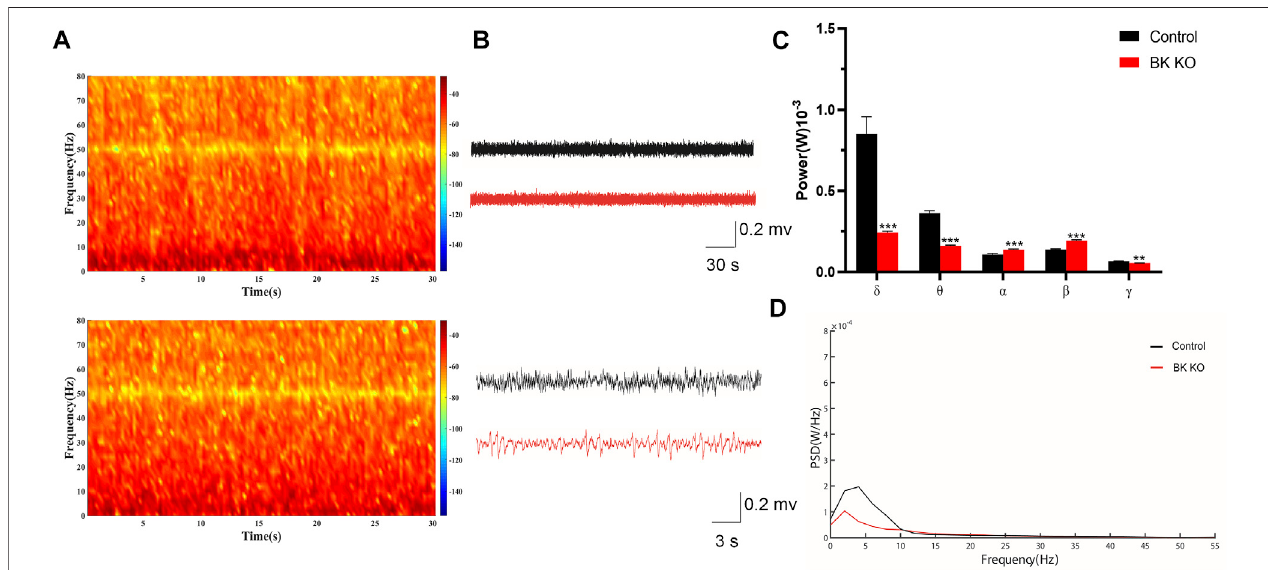
FIGURE6| Invivo multichannelEEGrecordingofmice. (A,B) FPsignalsandspectralheatmapsfromarepresentativeWT(black)andBKKO(red)miceareshown, respectively. (C) Spectral analysisofPSDvalues ondifferent frequency δ , θ , α , β ,and γ wavesin each group. (D) ThePSDofmice ineach group (Comparedwith control group, * p < 0.05, ** p < 0.01, *** p < 0.001, n (cid:2)